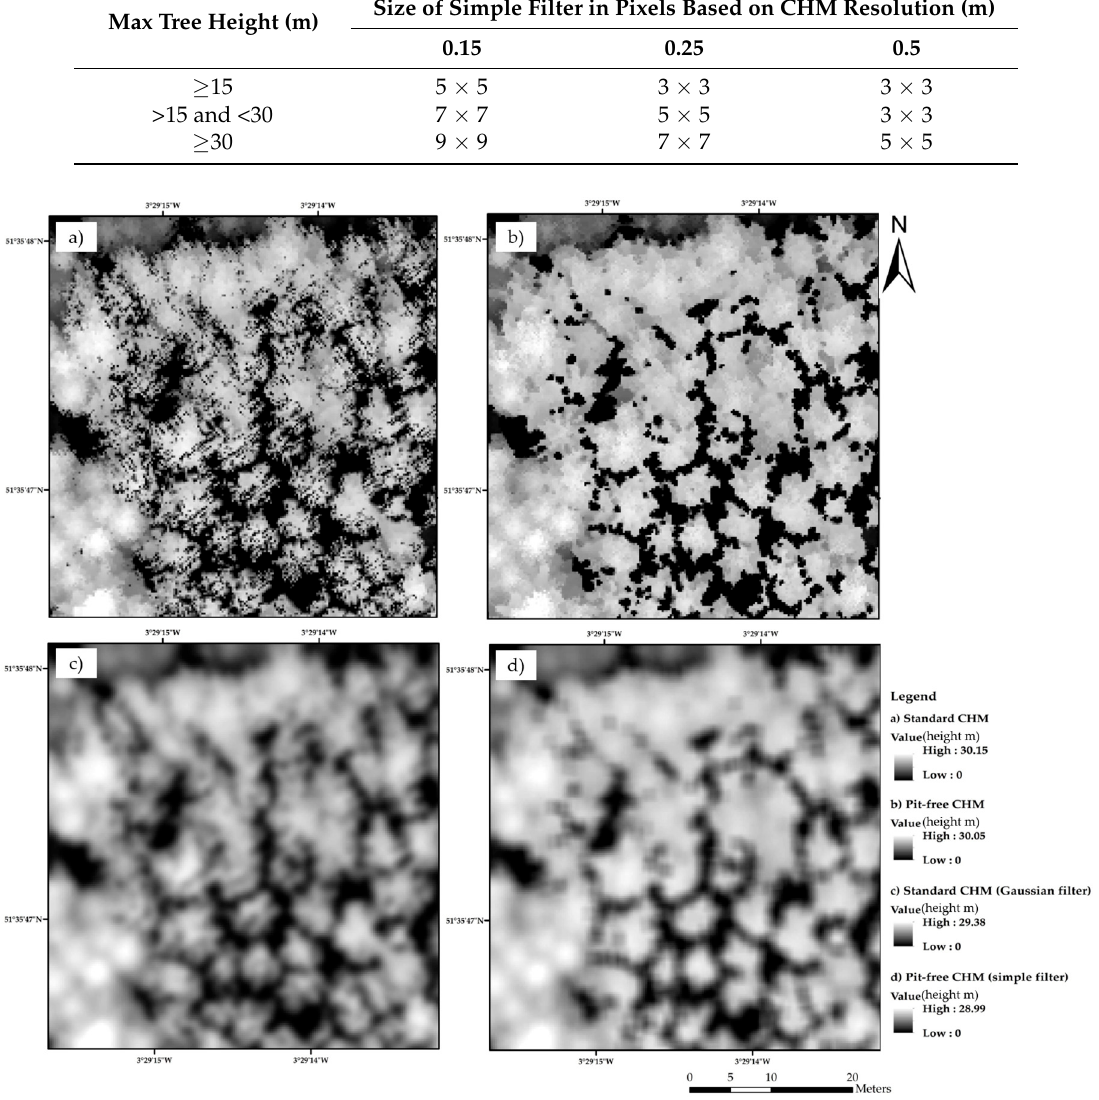
Figure 3. CHMs with 0.25 m resolution for Plot 4 (Ogmore Forest) heavily infected with P. ramorum : ( a ) standard CHM no filter; ( b ) pit-free CHM no filter; ( c ) standard CHM with Gaussian filter; and ( d ) pit-free CHM with simple filter. Legend presents the height (m) for each of the CHMs.